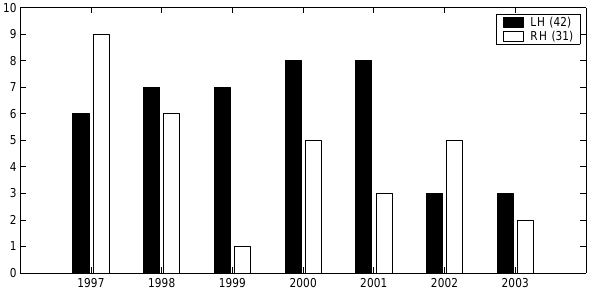
Fig. 4. Yearly distribution of left-handed (black) and right-handed MCs (white).